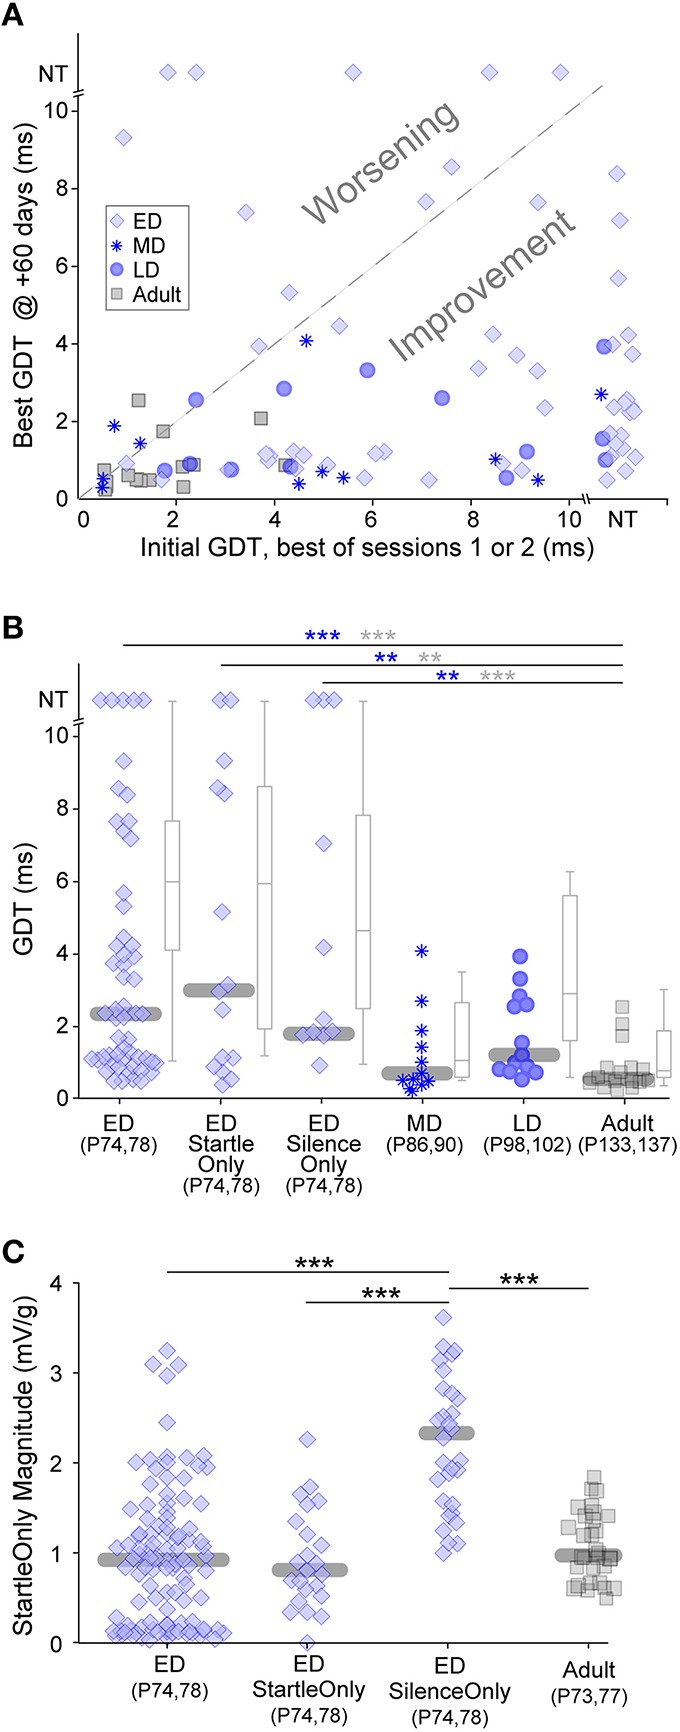
Long-lasting effects of the age of experience. All animals were tested 60 days after initial exposure. (A) Comparisons of initial and +60-day best GDTs separates animals that improved versus worsened based on early experience. Only ED animals worsened. NT = no threshold, indicating that the longest gap presented (10 ms) was not detected. (B) Symbols depict best GDTs and gray boxplots depict average GDTs across two testing sessions at +60-days, across developmental groups and two ED control groups. GDTs in all ED groups were higher than the Adult group. Blue and gray significance symbols refer to best and average GDTs, respectively. (C) The response magnitudes to startle stimuli without gaps were larger in the ED Silence-Only group than the other three groups serving as controls for the early testing experience. ***p < 0.004, ***p < 0.0002.